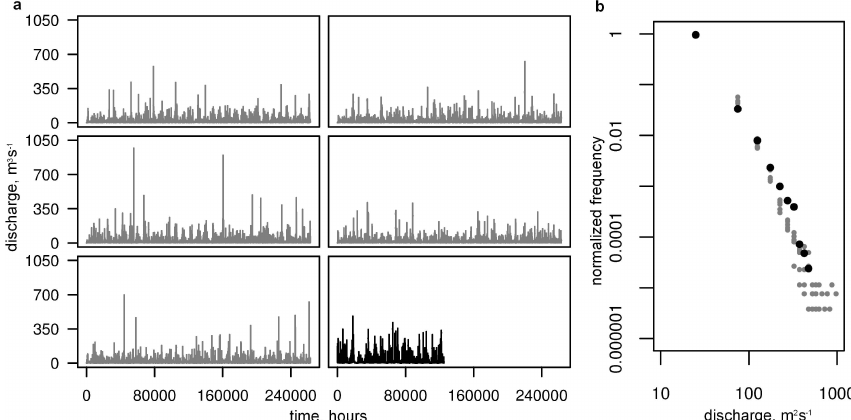
Fig. 2. Hydrographs (a) and histograms (b) from five baseline climate simulations (in grey), and observed discharge (in black). Histogram bin sizes for (b) are 50.